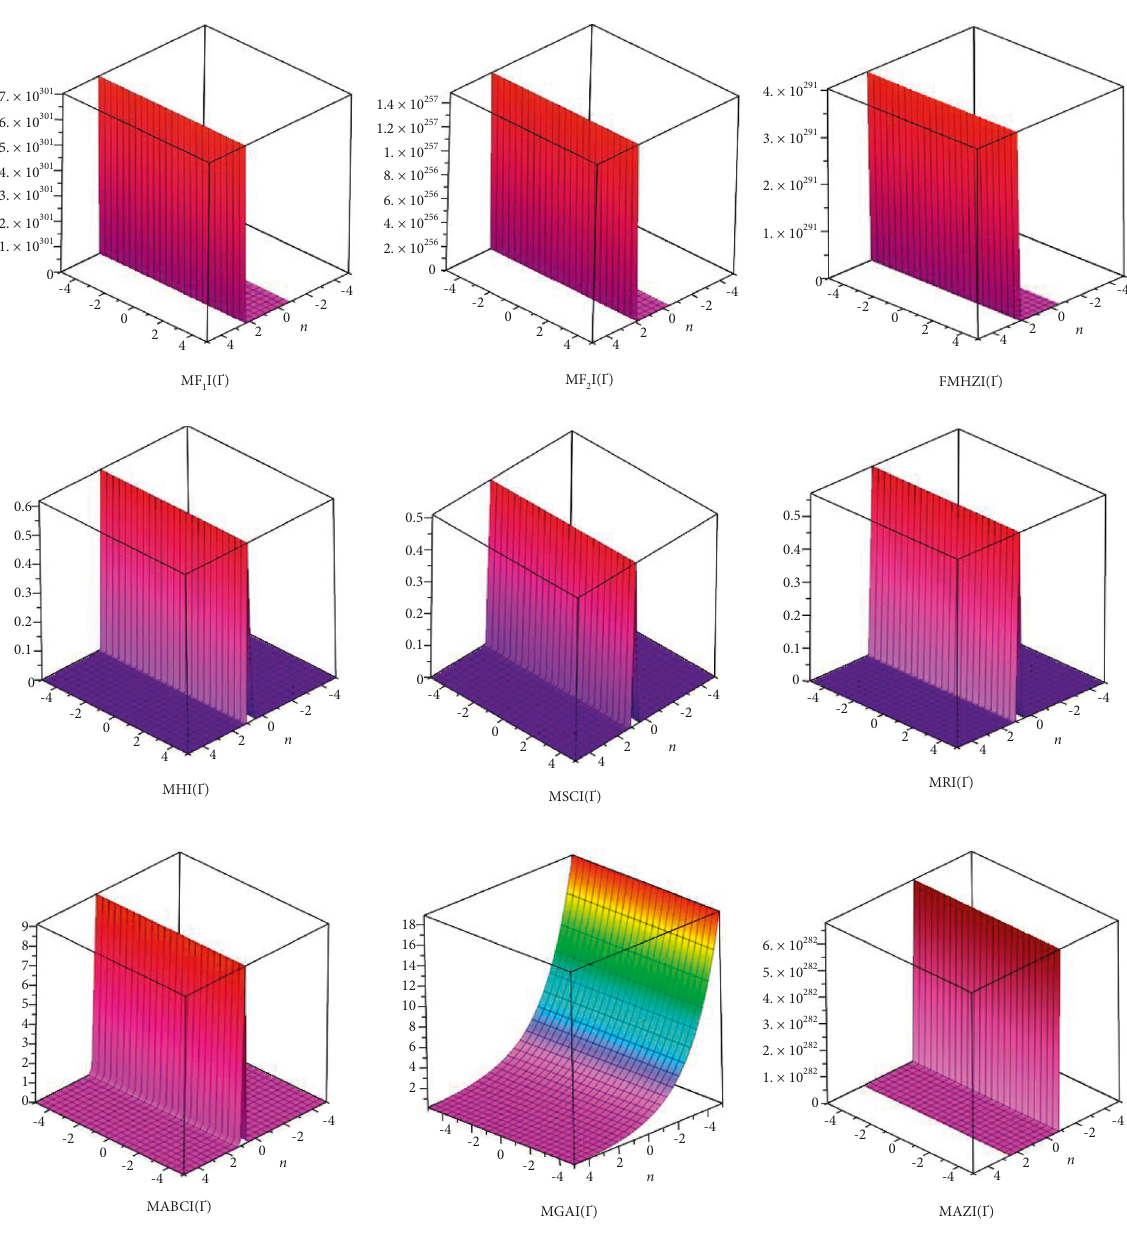
Figure 2: 3D graphical representations for Theorem